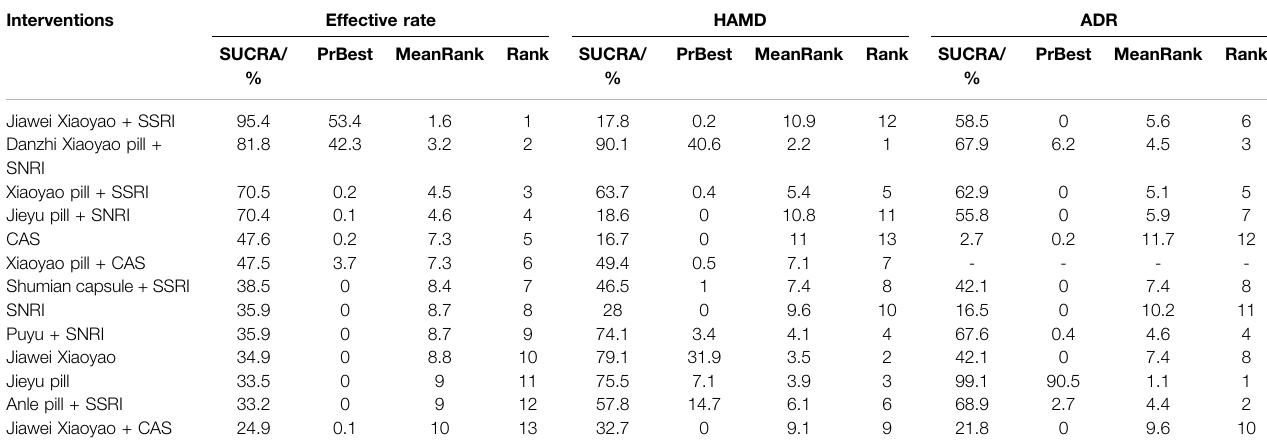
TABLE 3 | Ranking of network meta-analysis of effective rate, HAMD, ADR.